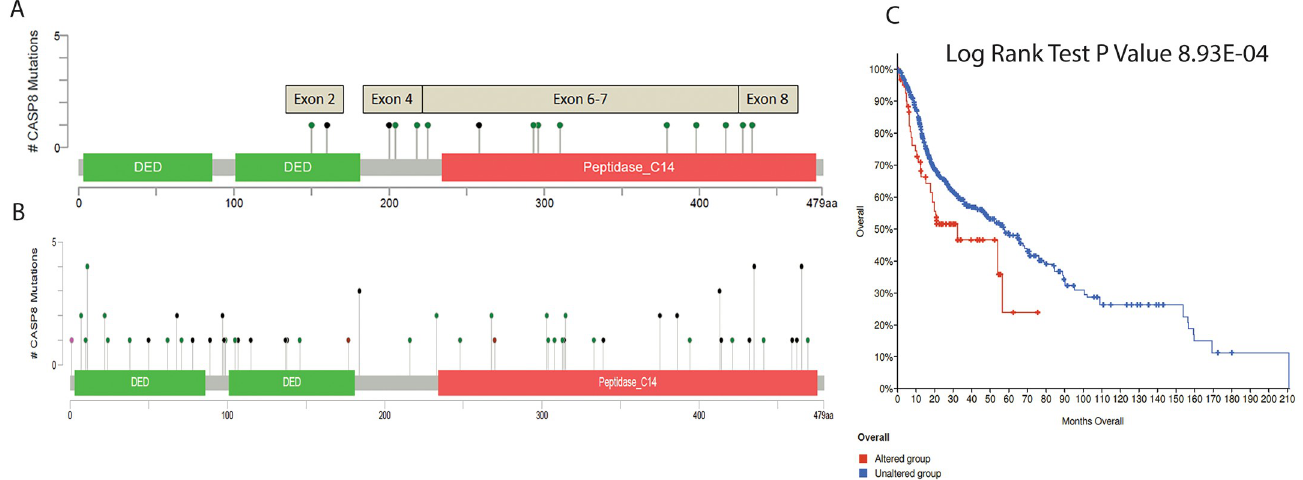
Fig 1. Schematic diagram of distribution of somatic mutations in CASP8 over different exons and protein domains. A . Somatic mutations (n = 15) were shown at different exons of CASP8 in the studied samples of oral cancer. Twelve green headed lines denote non-synonymous and stop-gain mutations. Three black headed lines denote frame shift mutations. B . Somatic mutations reported in HNSCC samples from TCGA cohorts. C . Overall survival rate of patients with and without CASP8 mutations in HNSCC samples from TCGA cohorts.